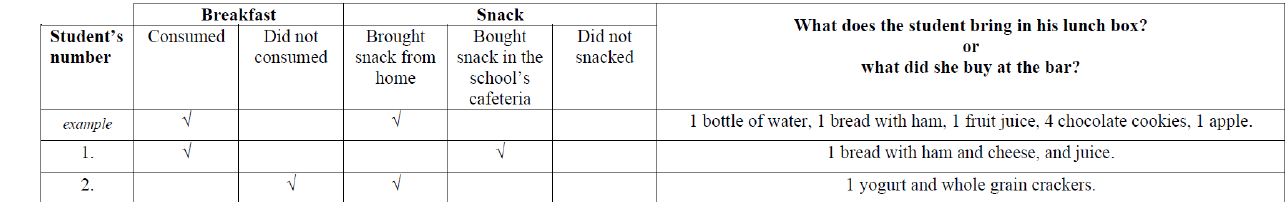
Figure 2. Example of a part of an observational grid.